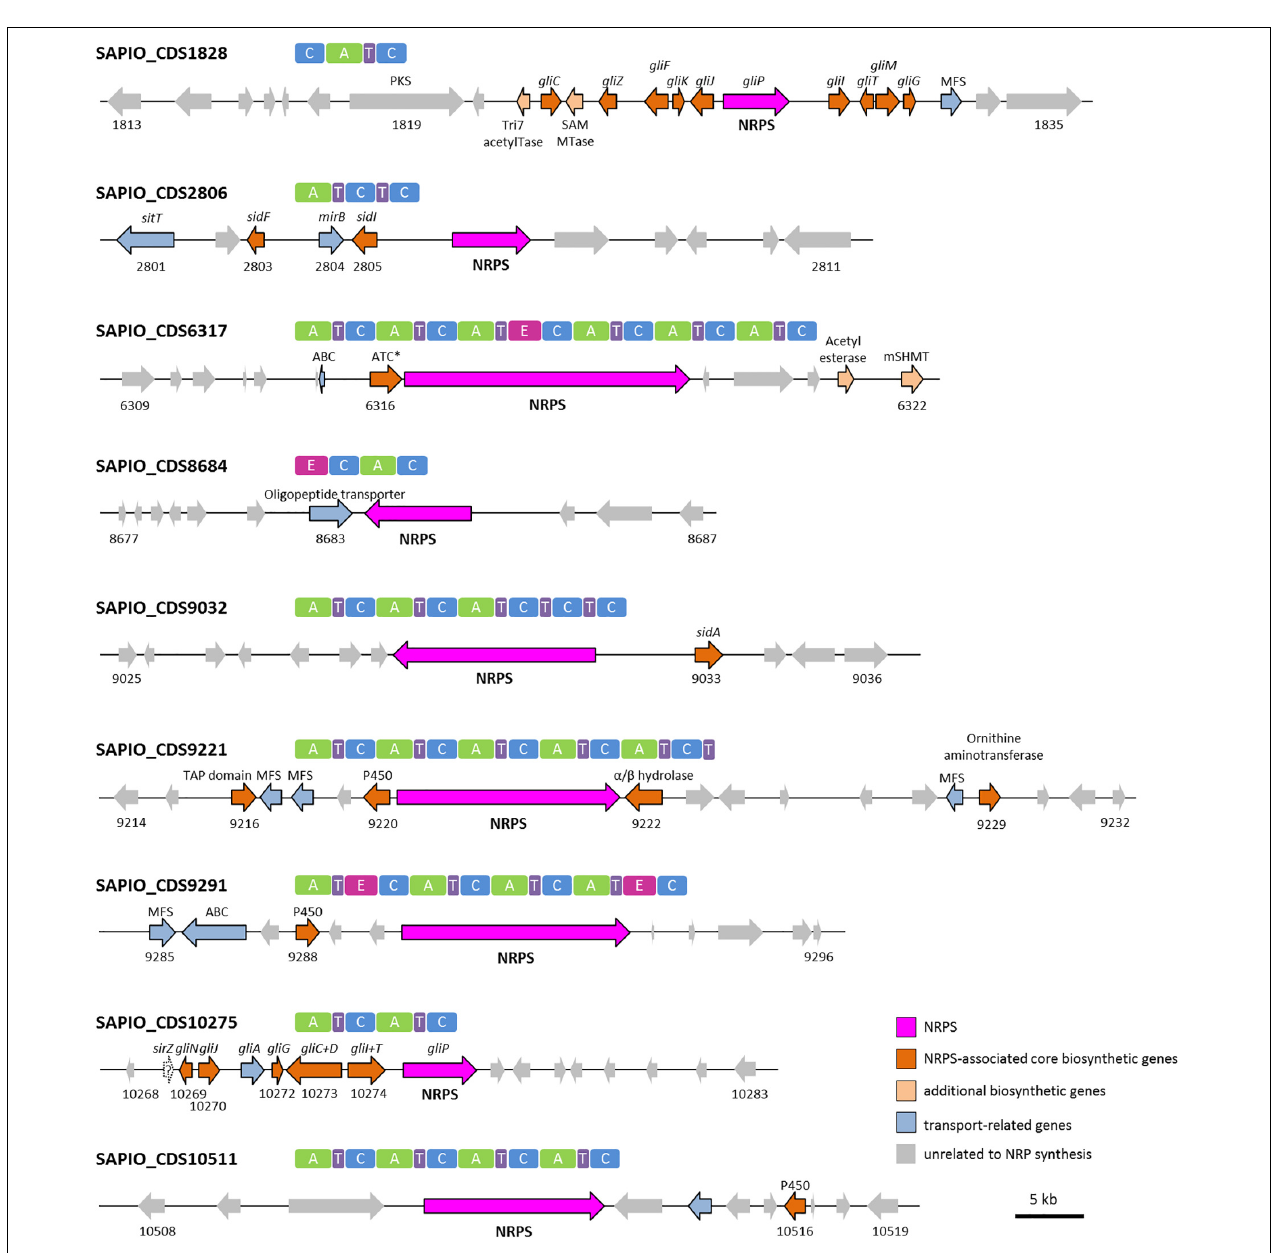
FIGURE 1 | NRPS genes and their domain architecture in Scedosporium apiospermum . Gene clusters shown are putatively involved in the biosynthesis of epidithiodioxopiperazines (CDS1828 and 10275), siderophores (CDS2806 and 9032), cyclopeptides (CDS6317 and 10511), and other unassigned derivatives (CDS8684, 9221 and 9291). All S. apiospermum NRPS genes are represented by pink/purple arrows. The minimal core module of an NRPS consists in an adenylation (A) domain for selection and activation of amino acids, a condensation (C) domain for catalyzing the formation of peptide bonds and a thiolation (T) domain for binding the amino acid building blocks. In addition to these standard modules, further structural variation can be introduced by optional domains such as epimerization (E) domains, which are responsible for conversion of L - to D -amino acids. Abbreviations: ABC, ATP binding-cassette; ATC ∗ , A-T-C module with truncated condensation domain; MFS, Major Facilitator Superfamily; P450, cytochrome P450 monooxygenase; mSHMT, mitochondrial serine hydroxymethyltransferase; SAM MTase, S-adenosyl-L-methionine-dependent methyltransferase; TAP, TAP-domain containing protein; Tri7 acetylTase, trichothecene